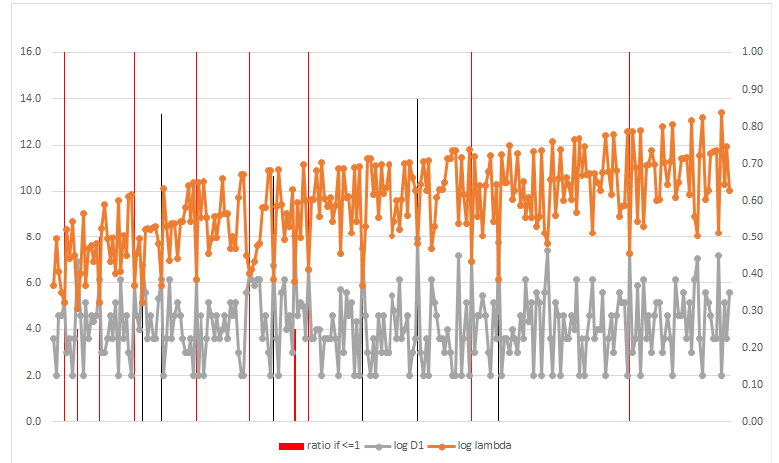
Figure 1. p 1 = 7, m = 3, p m ≤ 97.